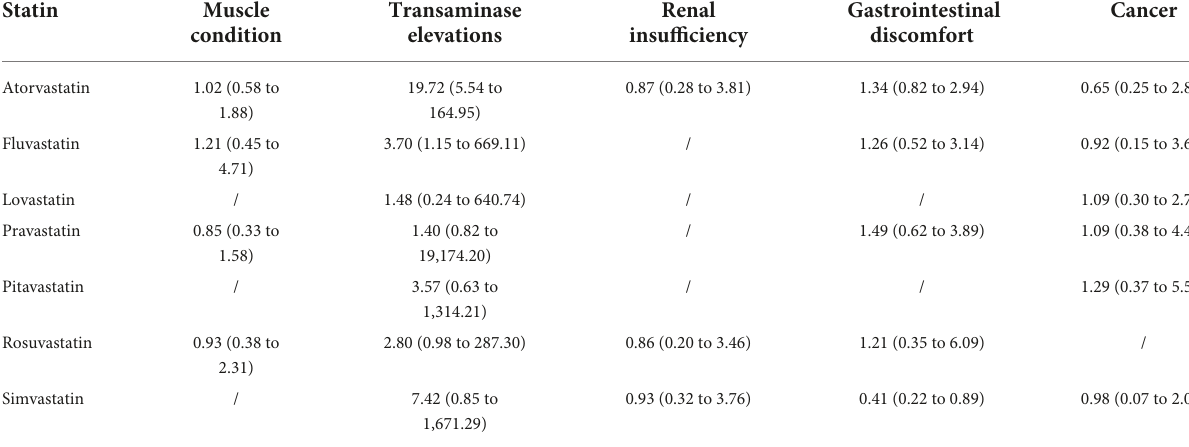
TABLE 2 Estimated maximum adverse effects of individual statins from Emax dose-response